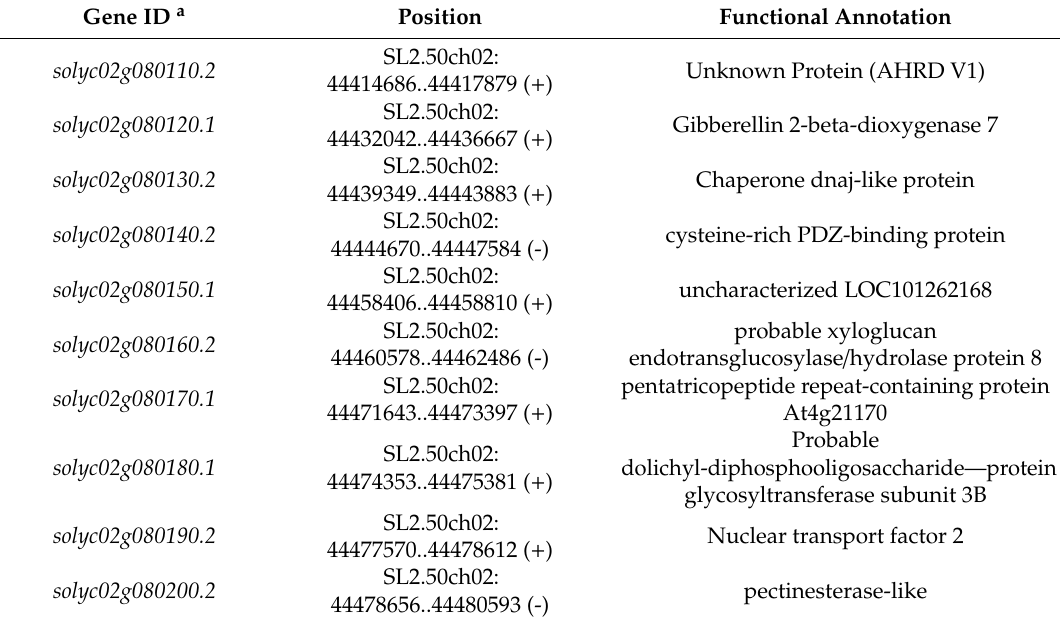
Table 3. Ten predicted genes in the 75.8-kb fine mapping interval according to the reference genome. Gene ID a Position Functional Annotation SL2.50ch02: solyc02g080110.2 Unknown Protein (AHRD V1) SL2.50ch02: Gibberellin 2-beta-dioxygenase 7